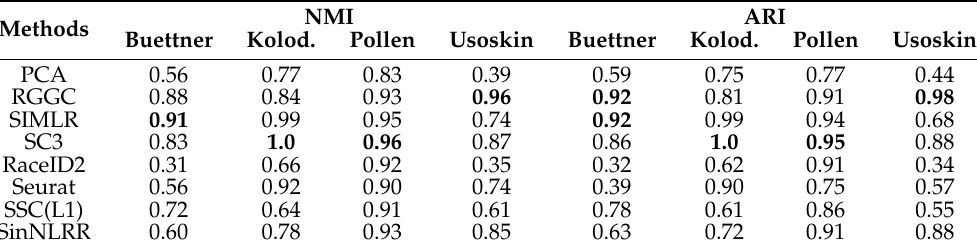
Table 3. Performance comparison of the four real single-cell data sets with 8 different clustering algorithms. Higher NMI and ARI values indicate better performance, and bold numbers indicate the best performance.